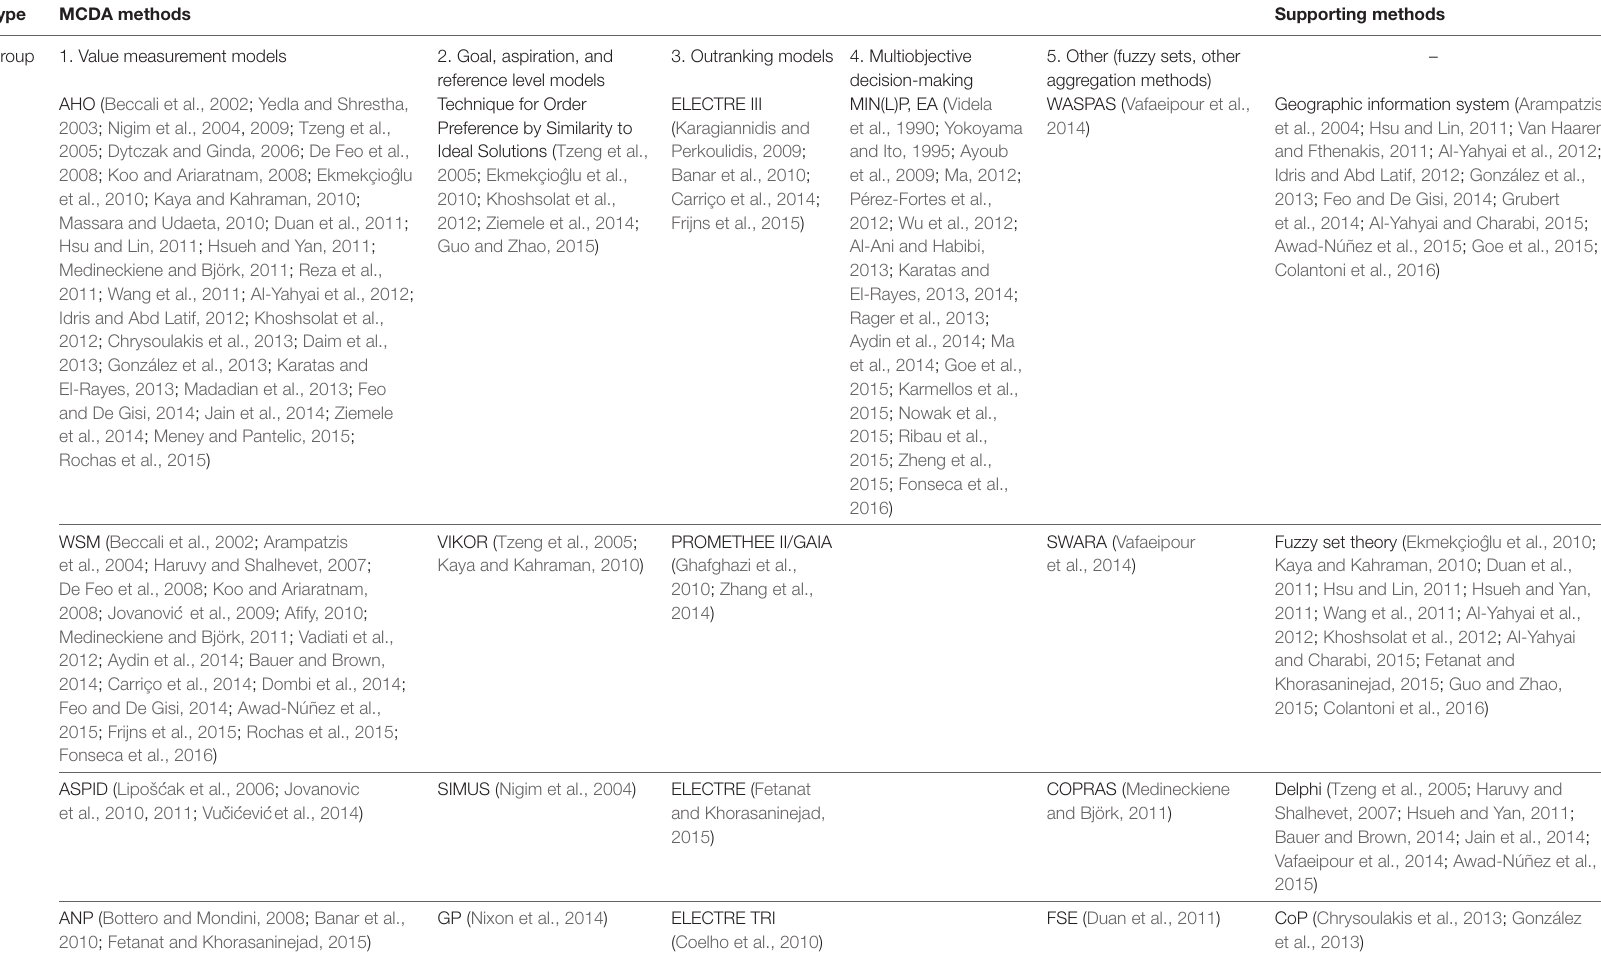
TABLe 2 | Classifications of multicriteria decision analysis MCDA and supporting methods and share of each class in the 89 studies reviewed.